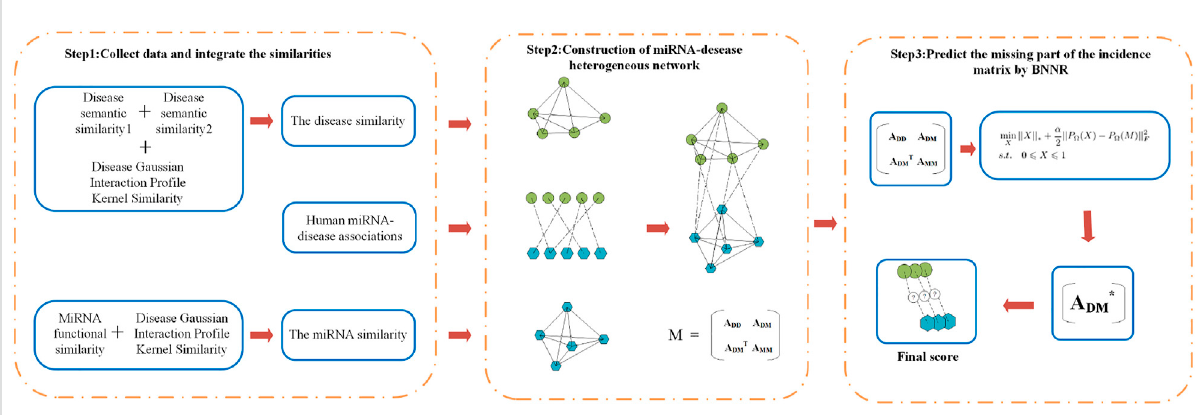
FIGURE 1 Flowchart of BNNRMDA. The fi rst step collects the information of known miRNA – disease associations, the disease similarity and the miRNA similarity. The second step constructs a heterogeneous miRNA-disease network. The third step uses a matrix completion method BNNR (bounded nuclear norm regularization) to calculate a score for the miRNA-disease pairs with unknown